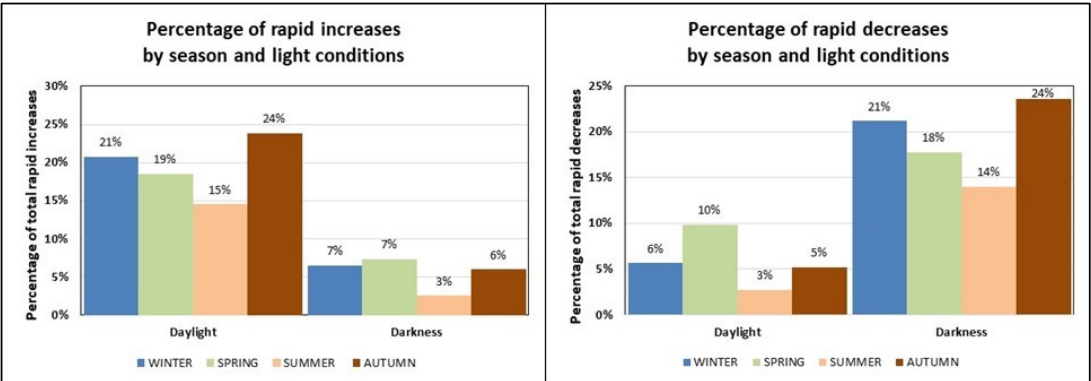
Figure 5. Percentage of rapid increases ( left ) and rapid decreases ( right ) by light conditions and season.